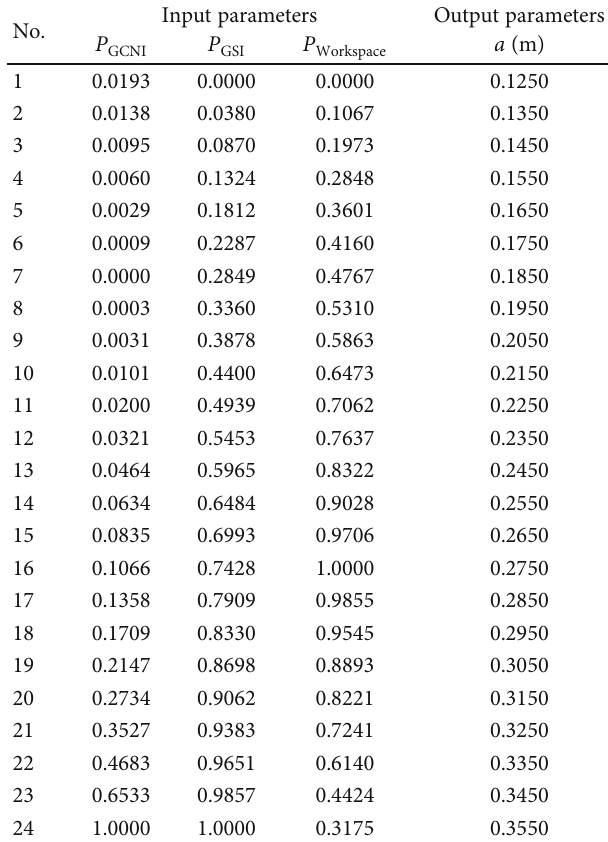
Table 1: The part of training